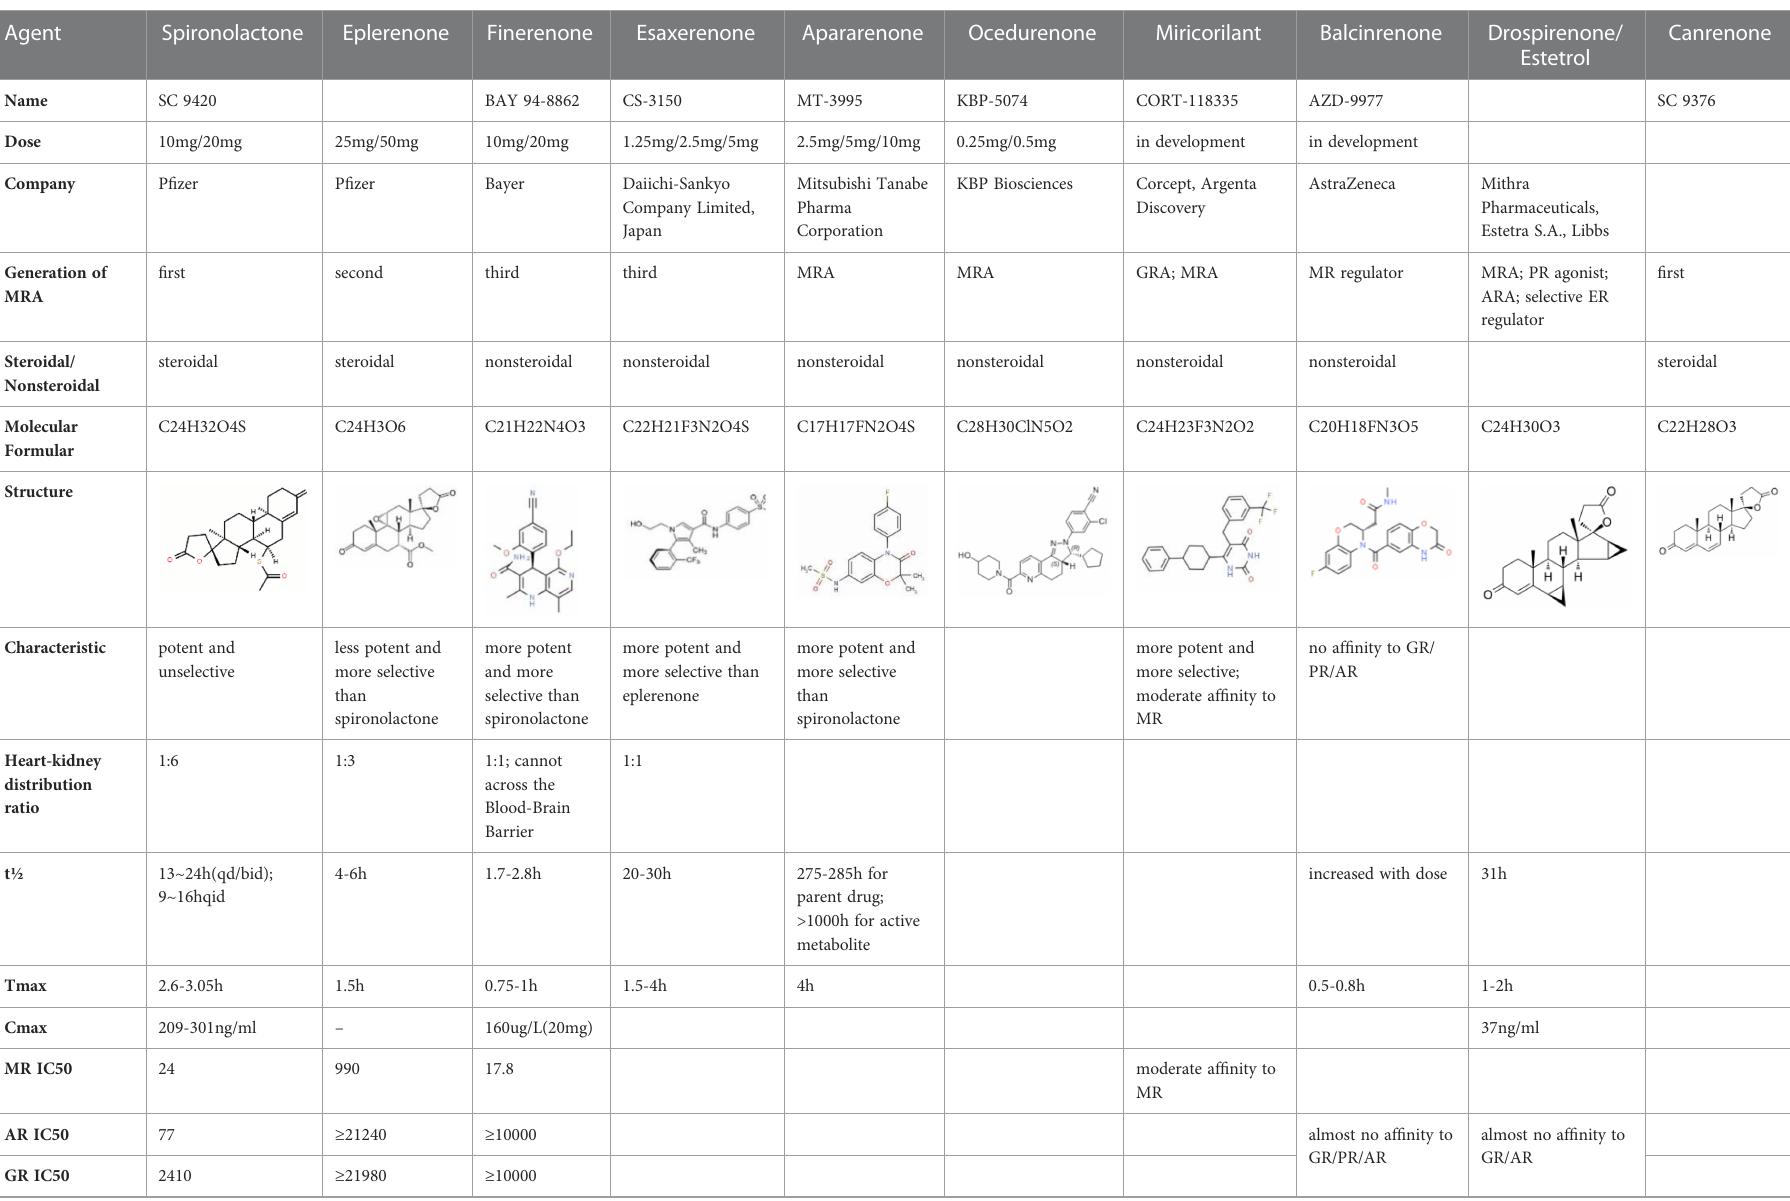
TABLE 1 The Pharmacokinetics of